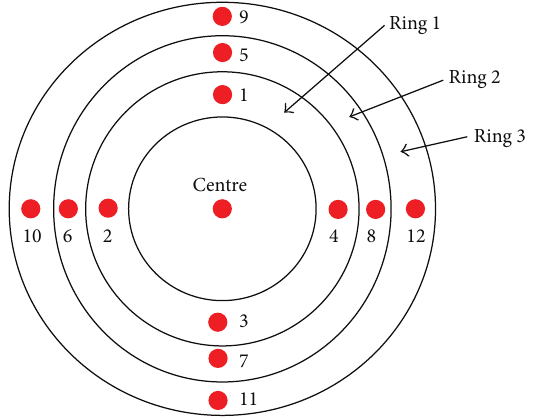
Figure 6: Measuring points on the inner surface of the Fresnel lens.